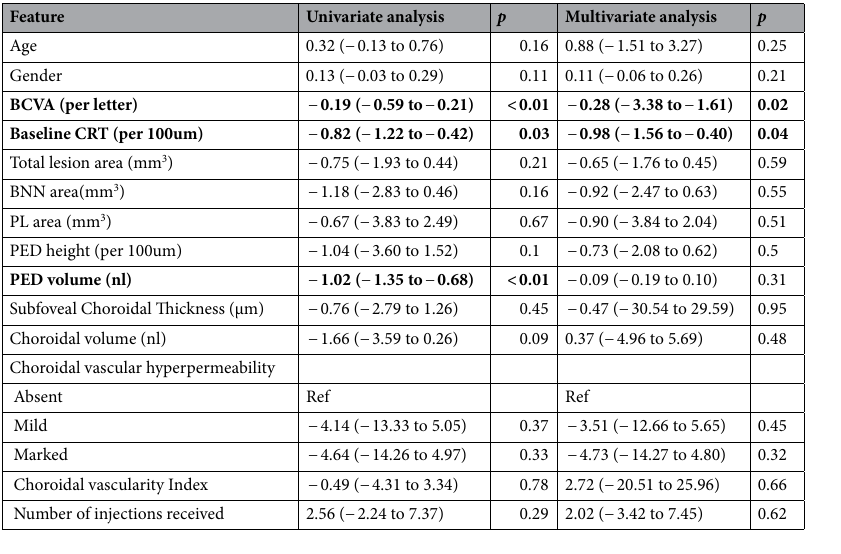
Table 2. Linear regression analysis of baseline characteristics against BCVA change at month 12. BNN branching neovascular network, PL polypoidal lesion, CRT central retinal thickness, PED pigment epithelium detachment, CVH choroidal vascular hyper-permeability; CVH defined as marked = presence of patchy hyper fluorescence with blurred margins persisting from the mid to the late phase ICGA, mild = fuzziness of choroidal vessels in mid-phase ICGA but no patchy hyper fluorescence in late phase, absent = none of the above features present; CV choroidal volume; CVI choroidal vascularity index. Multivariate analysis adjusted for age and sex. Bold font denotes parameters significantly influencing the change in BCVA at month 12 from baseline and are retained in the final multivariable